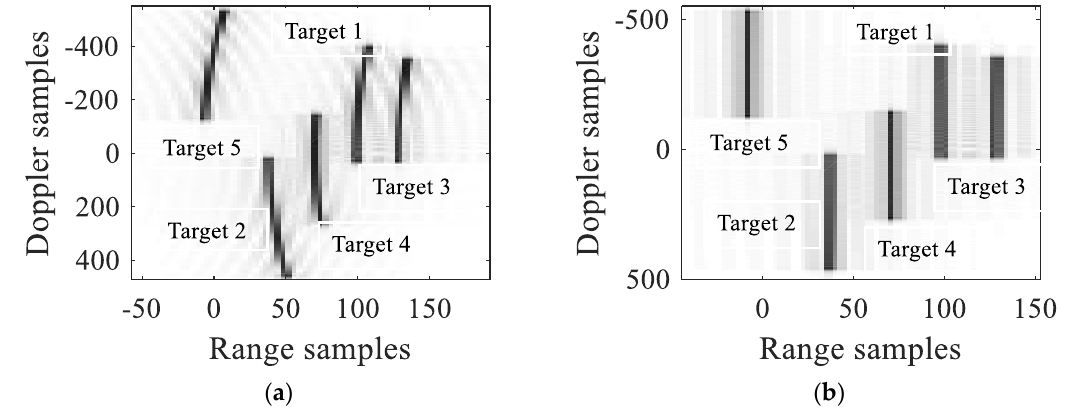
Figure 7. RCMC results. ( a ) Five targets before RCMC; ( b ) Five targets after RCMC.